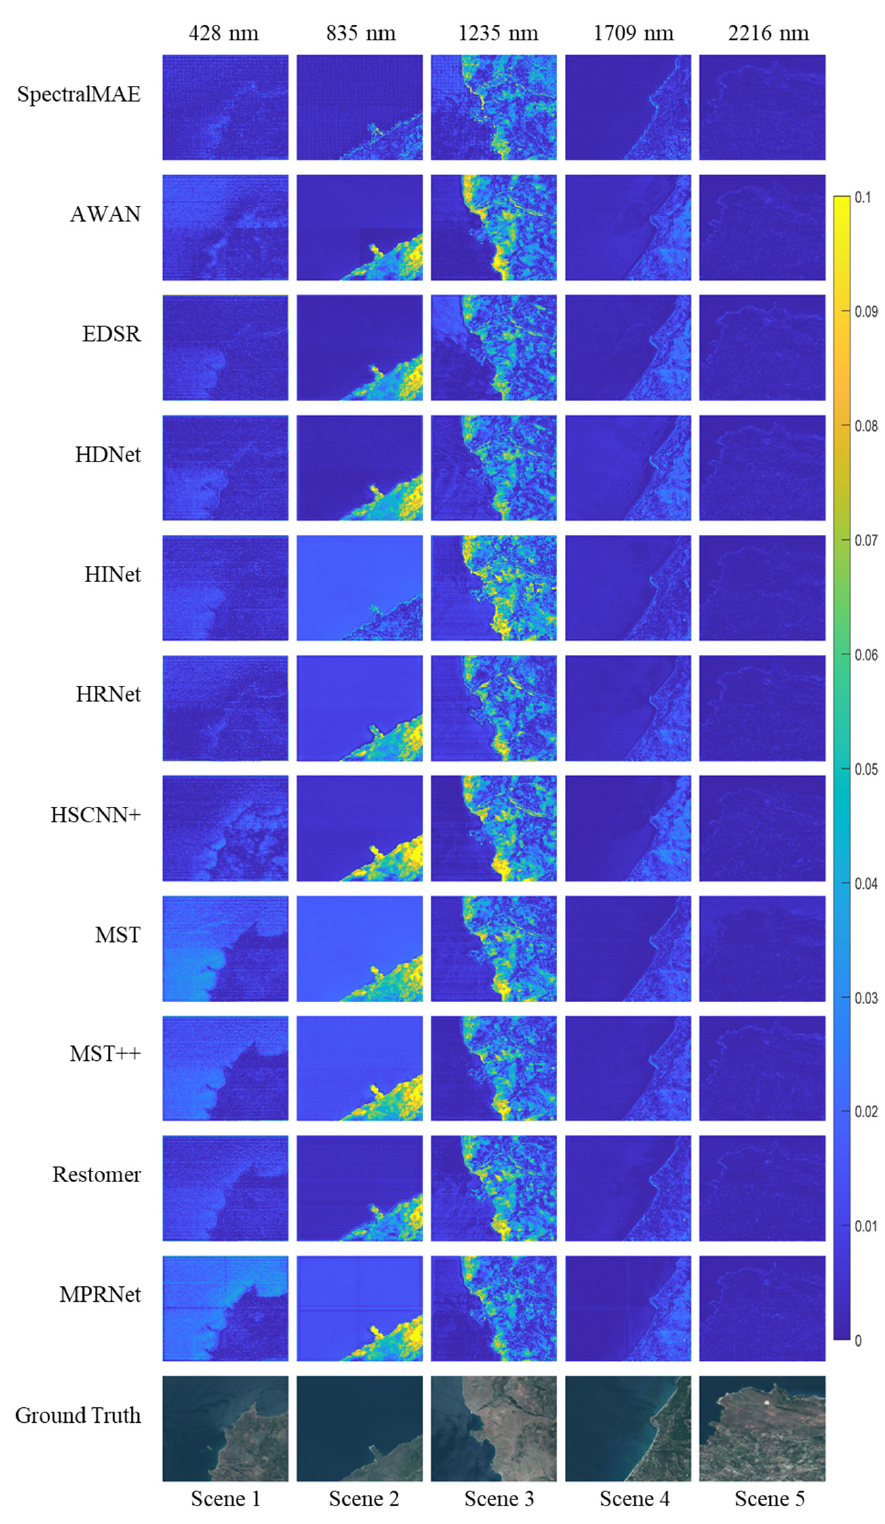
Figure 7. Visualization of the error maps between ground truth and reconstructed results on the HyRANK dataset with only three channel inputs.